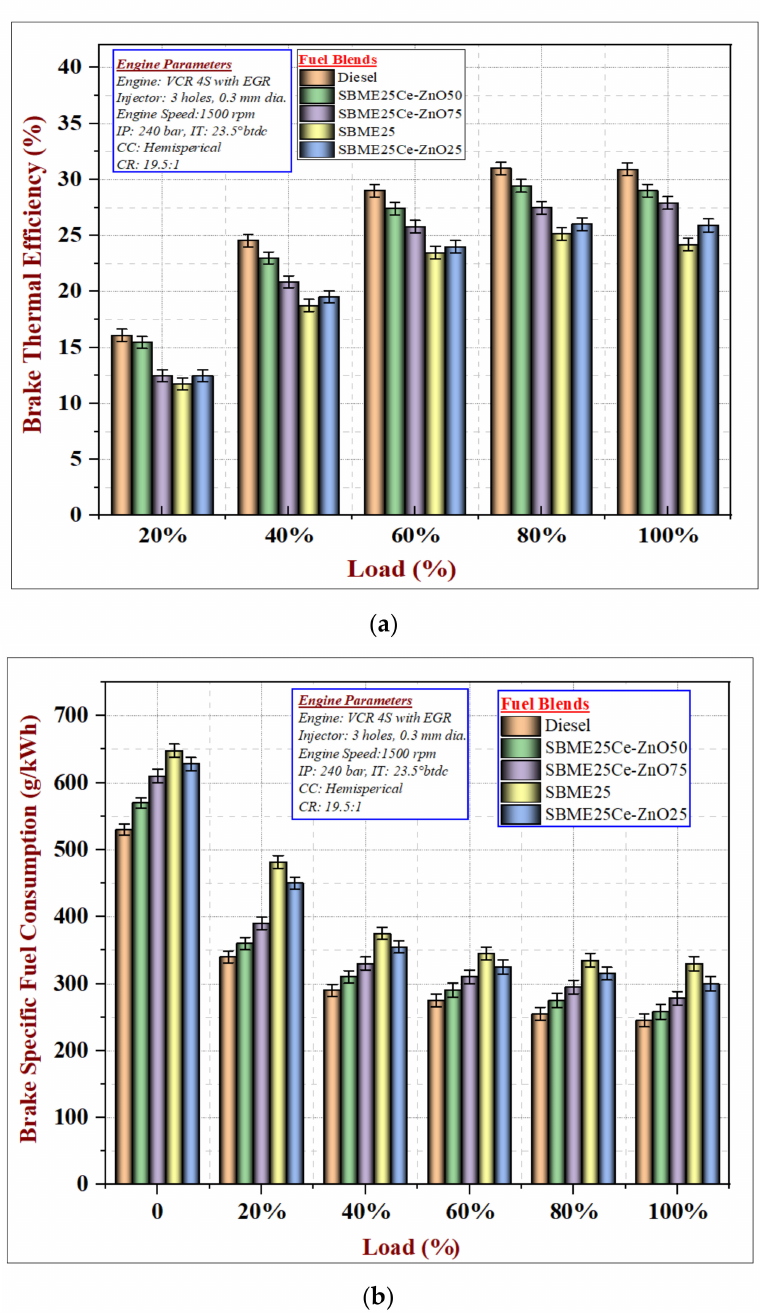
Figure 9. Variation with load for di ff erent fuel blends of: ( a ) BTE; and ( b )